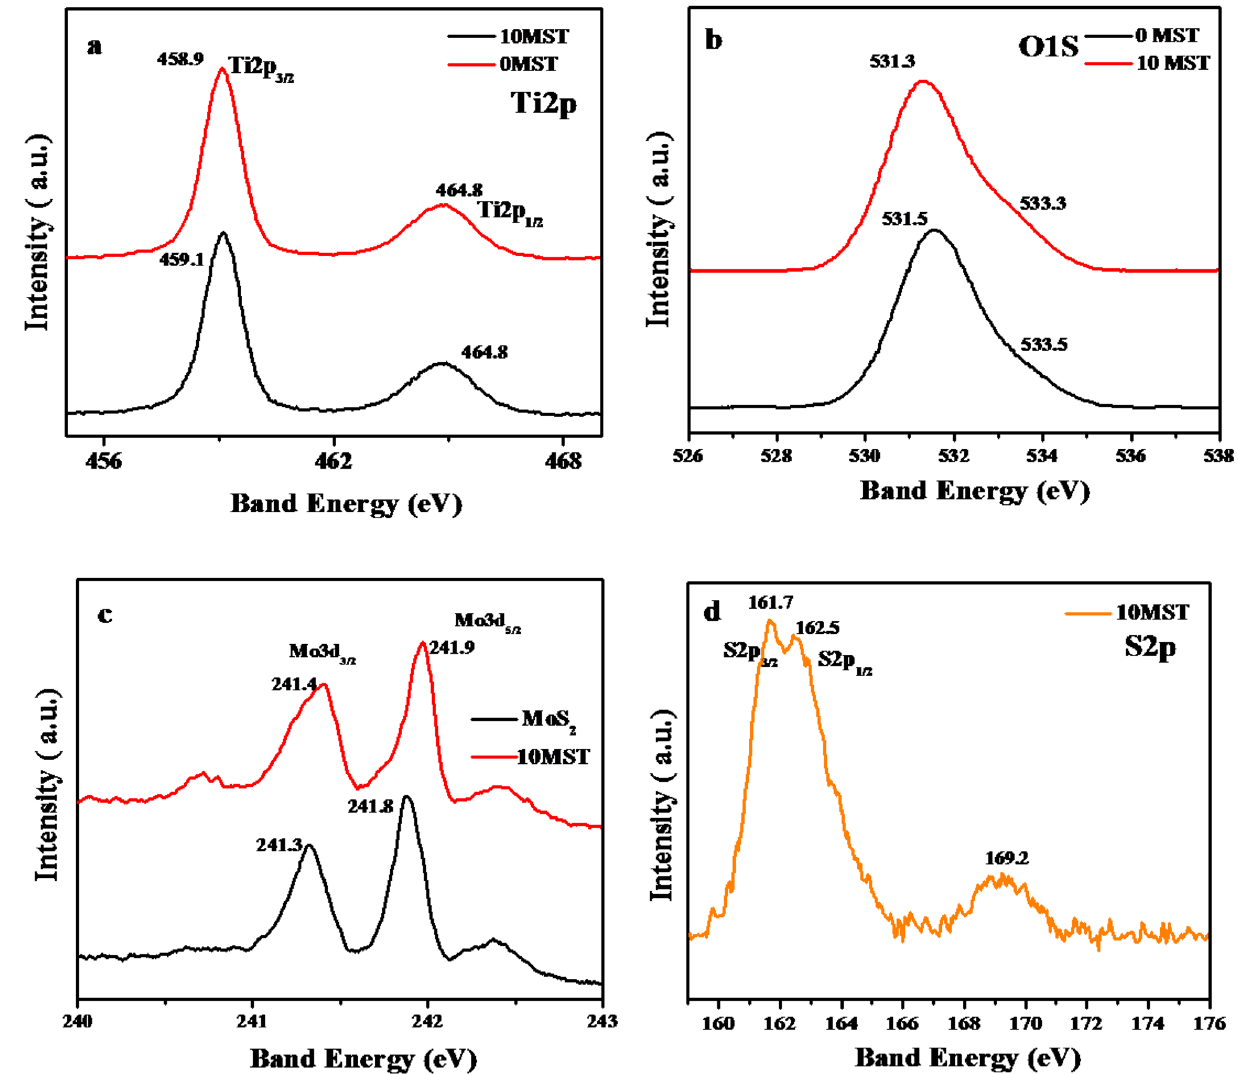
Fig. 8 XPS analyses for the 0 MST, 10 MST and MoS